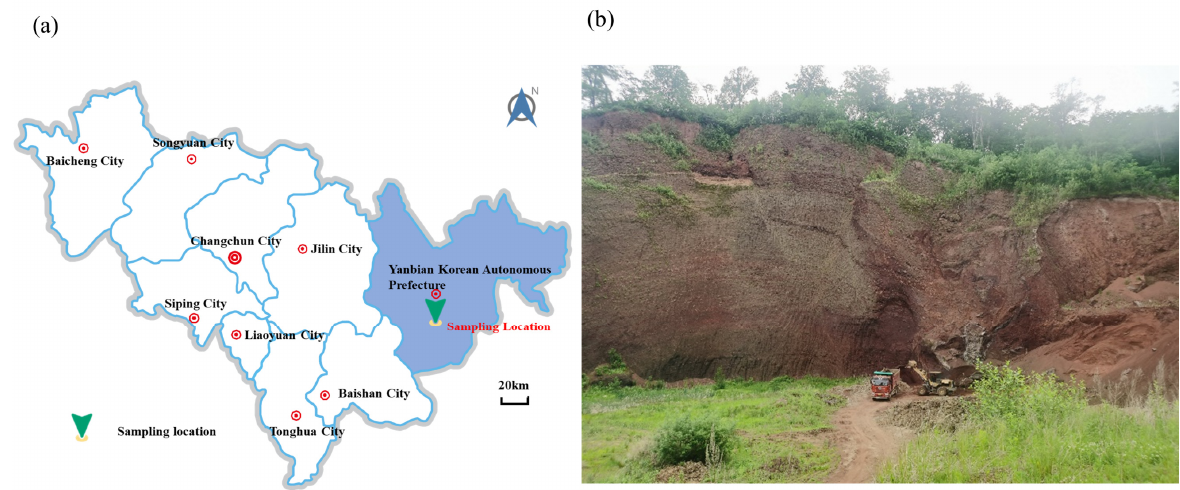
Figure 1. Sampling location map. ( a ) Location map; ( b ) Artificial slope.